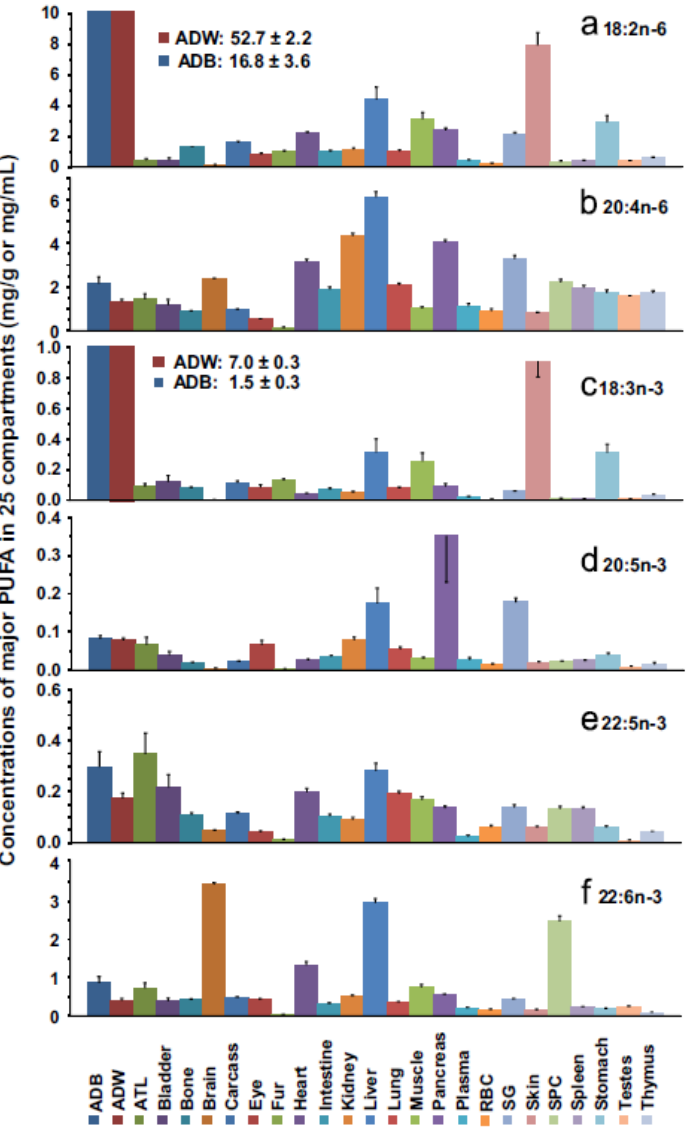
Figure 2. Distribution of fatty acids in 25 different tissue compartments in young male rats. Abbreviations: ATL, adrenal gland, thyroid gland, mandibular gland, and lymph nodes; RBC, red blood cell; SG, salivary gland; ADB, brown adipose tissue; ADW, white adipose tissue (from Salem et al. [52]).